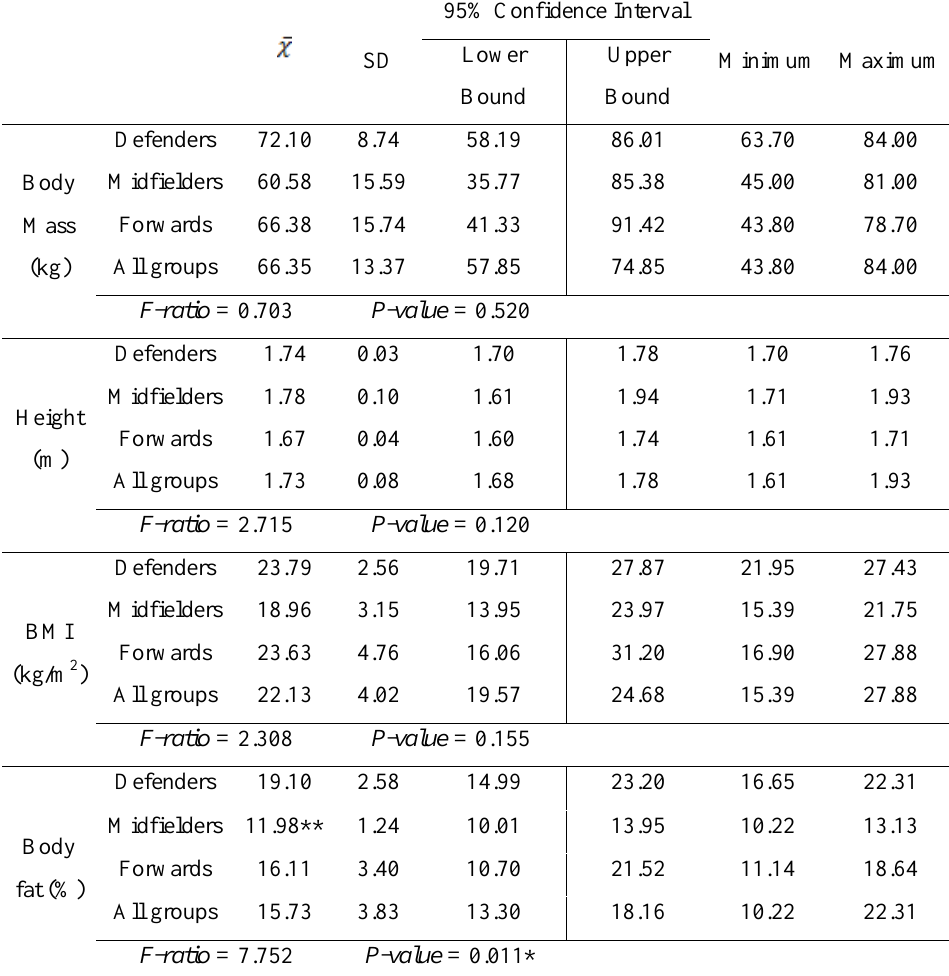
Table 2. Anthropometric characteristics of Brazilian amputee soccer